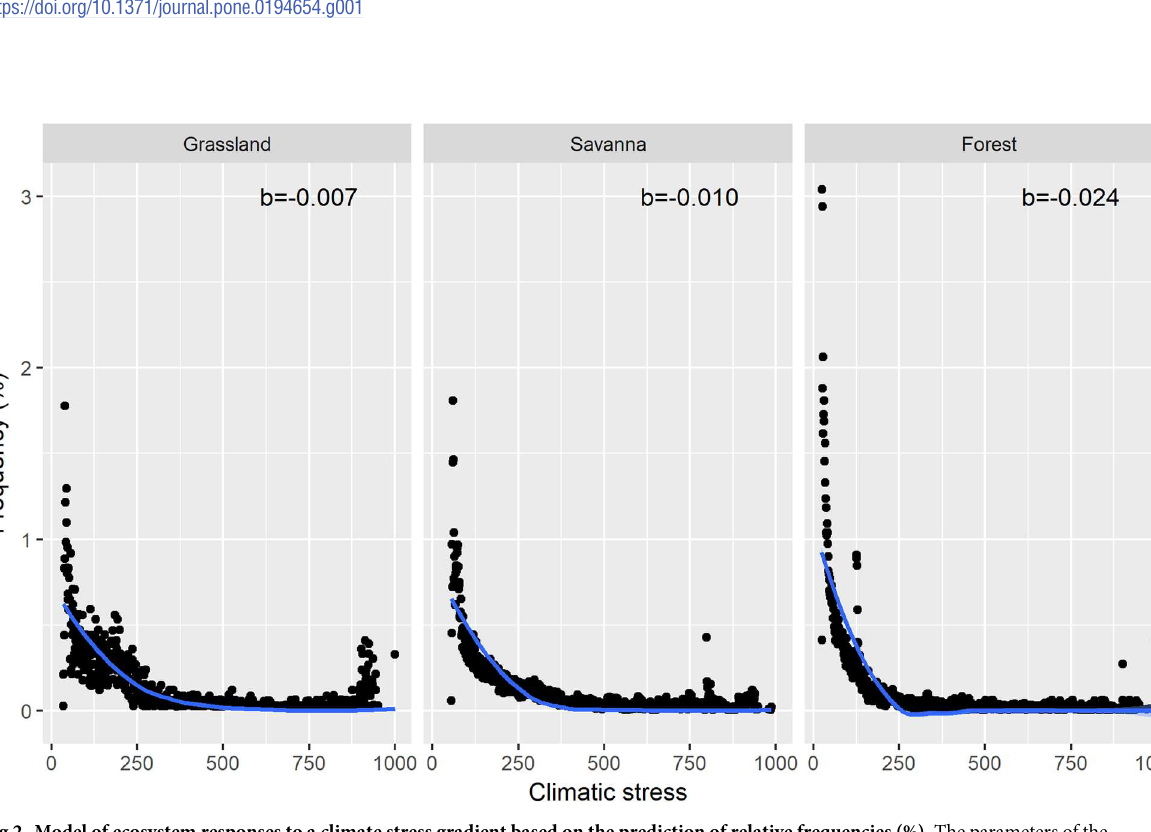
Fig 1. Ecosystem resilience based on the climatic niche projected under geographic space. A Grasslands; B Savannas; C Forest. High values (~1000) indicate a high recovery capacity after a disturbance, whereas low values (~zero) mean slower recovery capacity after a disturbance.